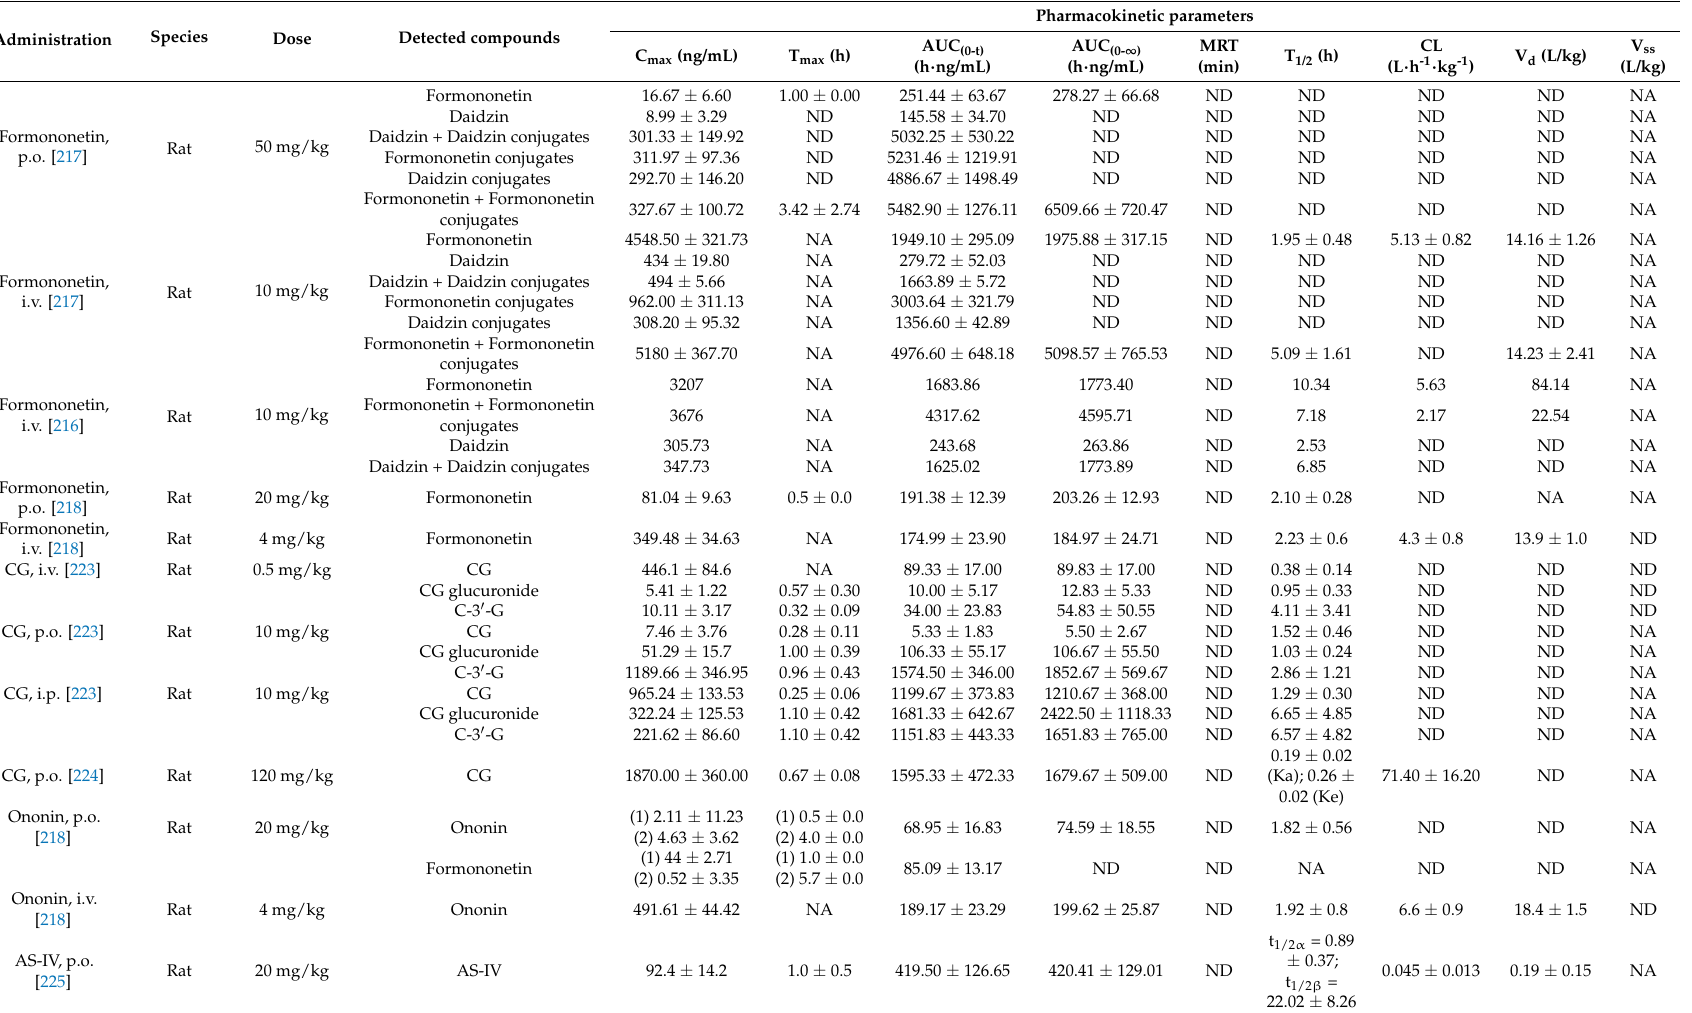
Table 3. Pharmacokinetic parameters of detected compounds following oral/intravenous/intraperitoneal administration of bioactive compounds from AR. Administration Species